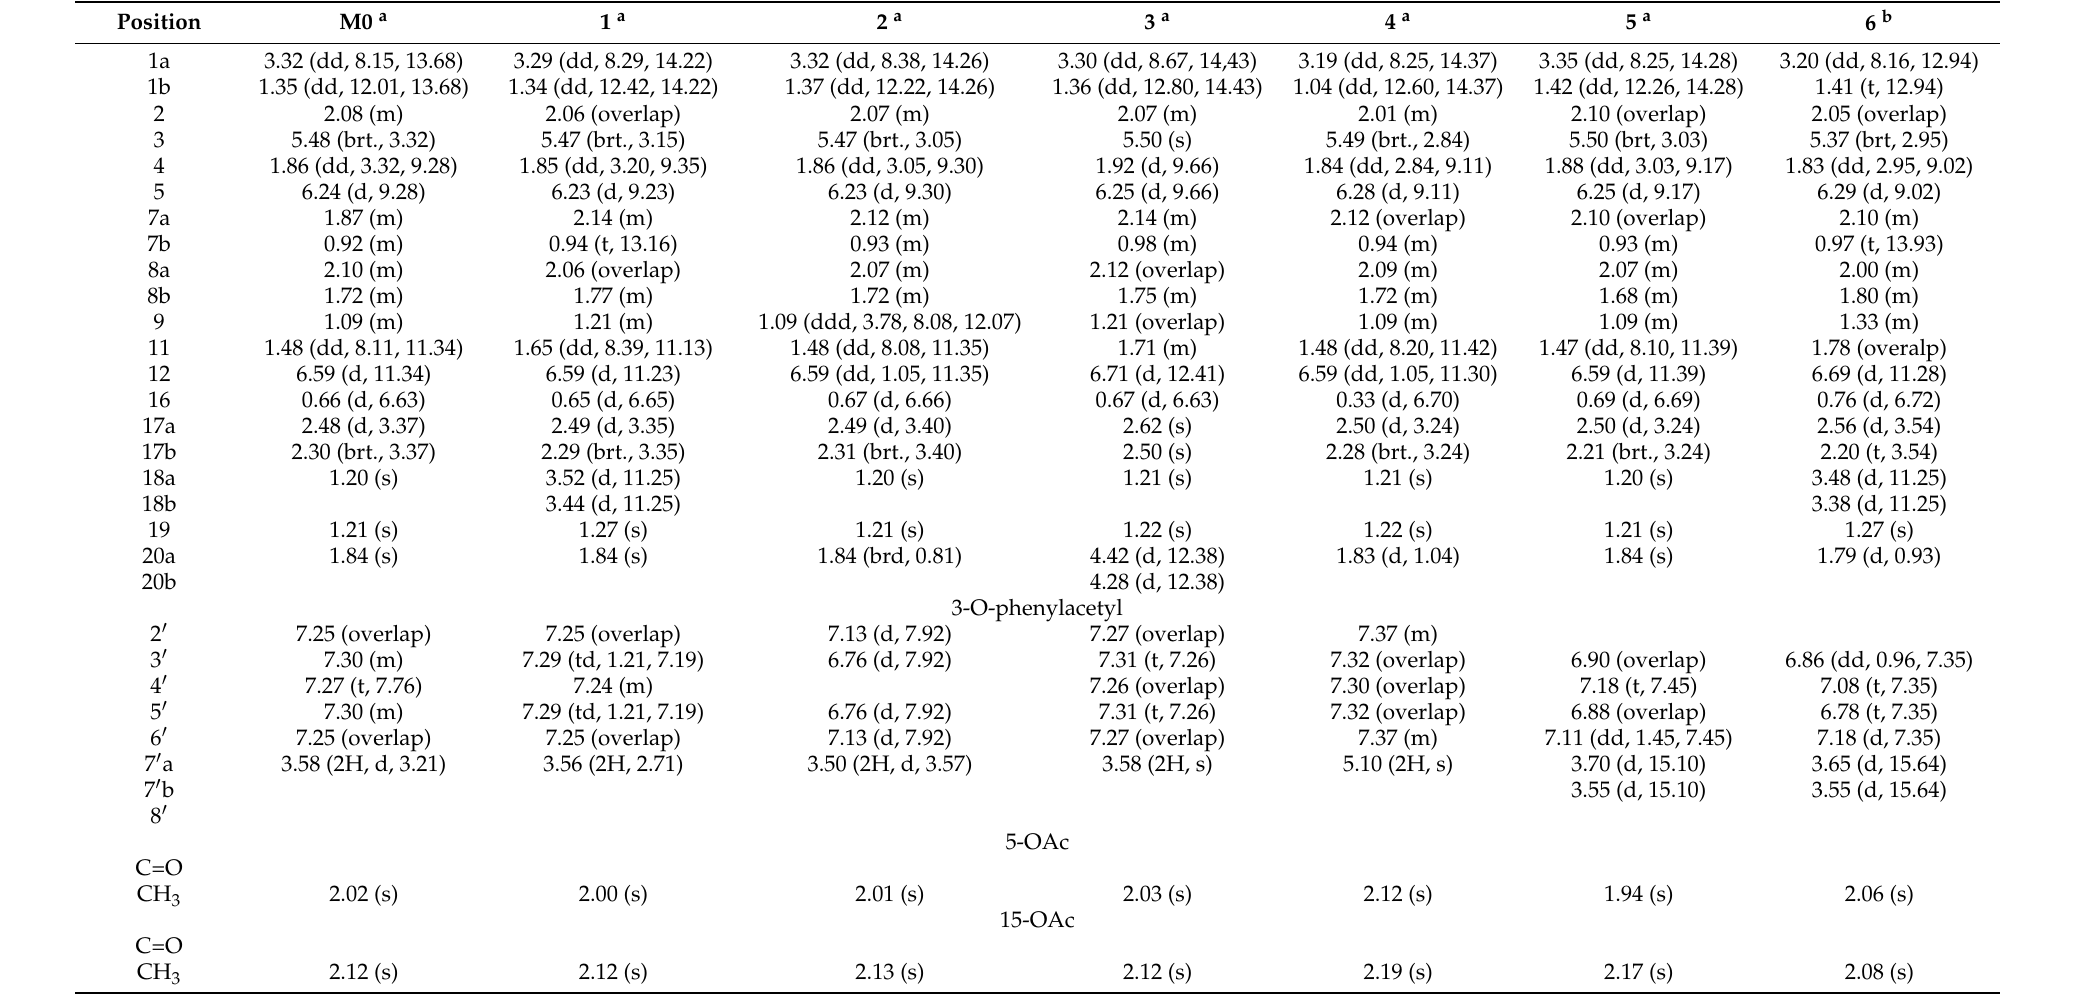
Table 1. The 1 H NMR data for euphorbiasteroid and its transformation products ( 1 – 6